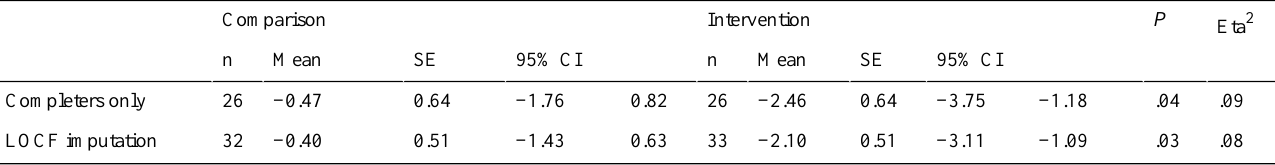
Table 5. Adjusted weight change (kg) at 4 months using two missing-data methods, by group